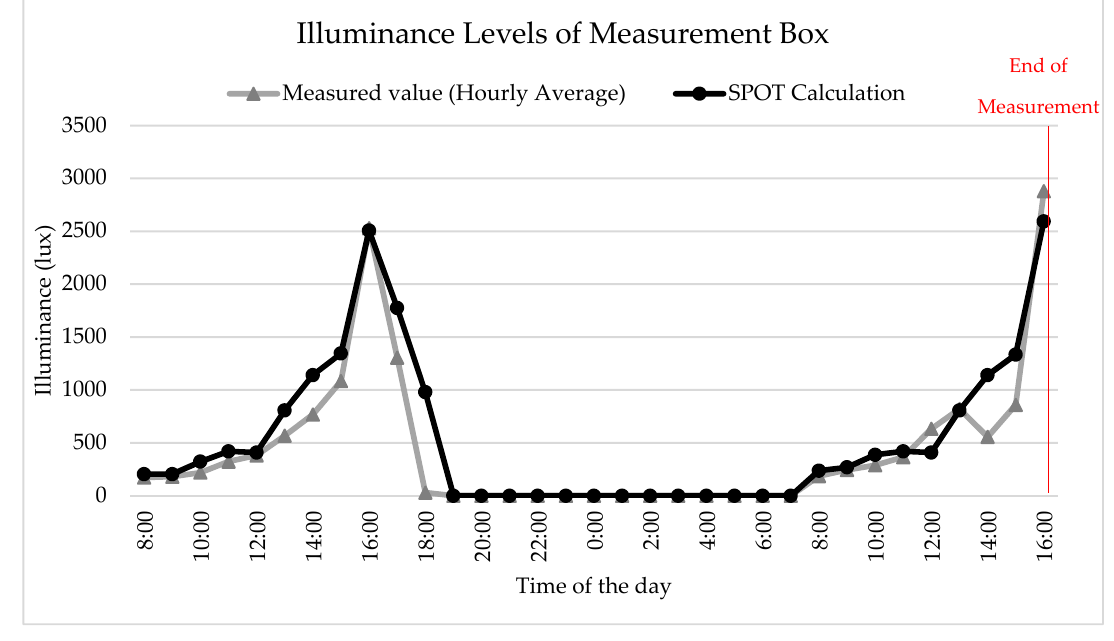
Figure 2. Illuminance Levels of Measurement Box within a Two-Day Measurement Compared to SPOT Calculation.